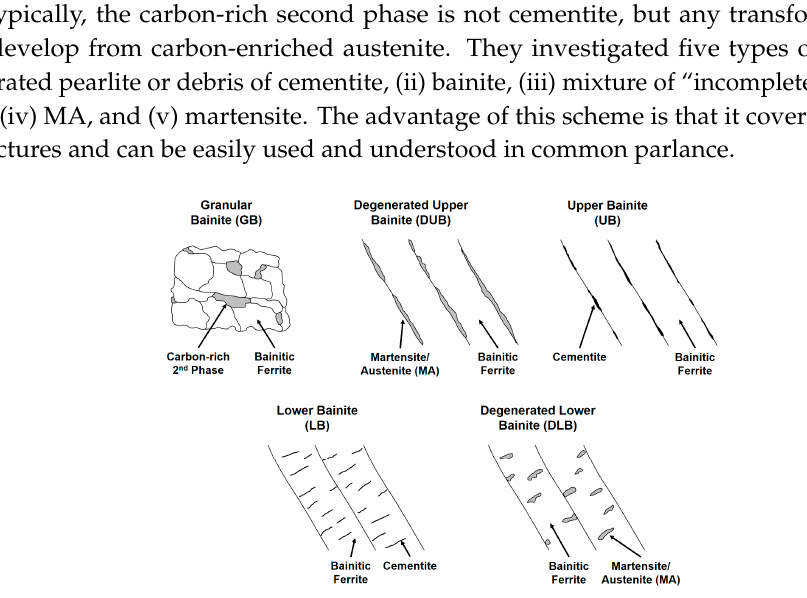
Figure 1. Schematics of the 5 bainite types suggested by Zajac [7]. Diagram is modified according to [7].